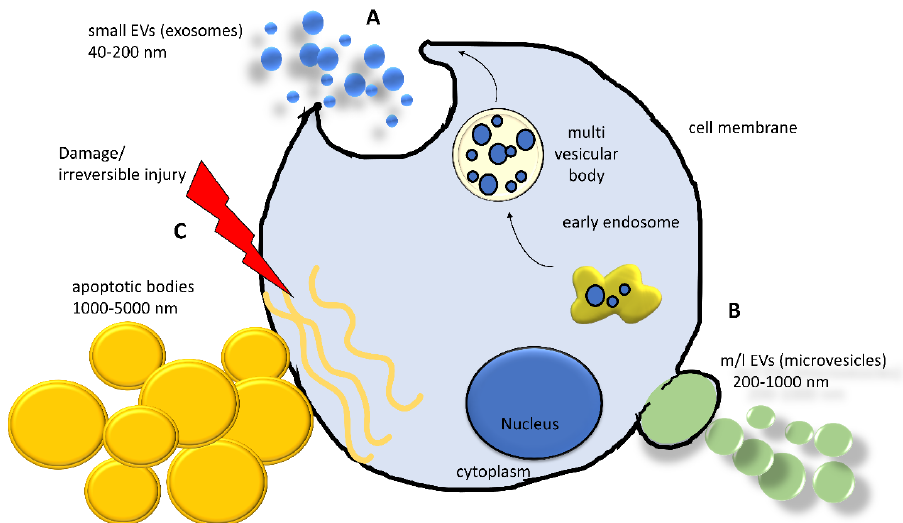
Figure 2. Schematization of the biogenesis and formation of the main classes of extracellular vesicles (EVs) released from a cell. ( A ) Early endosomes involved in the sorting and recycling of canonical intracellular vesicles can generate a multivesicular body (MVB), entrapping vesicles. An MVB can fuse with plasma membrane releasing its content in extracellular space. ( B ) Plasma membrane can undergo a complex remodeling by sophisticated molecular machinery, generating a bud from which a microvesicle is formed. ( C ) When a cell experiences a severe injury triggering irreversible damage, the cell activates the apoptotic pathway implying the organized dismantling of the cytoplasm. This process induces the release of the apoptotic bodies. sEVs = small extracellular vesicles; m/lEVs = medium/large extracellular vesicles.